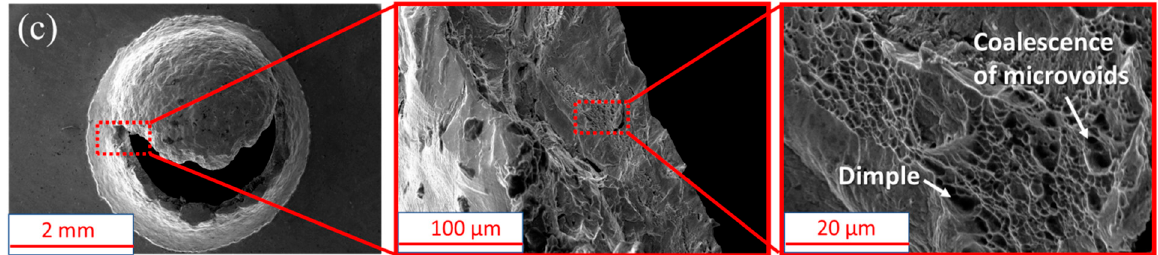
Figure 8. SEM image for three materials. ( a ) 316L stainless steel; ( b ) 347L stainless steel; ( c ) Co 32 Cr 28 Ni 32.94 Al 4.06 Ti 3 . Ni 32.94 Al 4.06 Ti 3 .